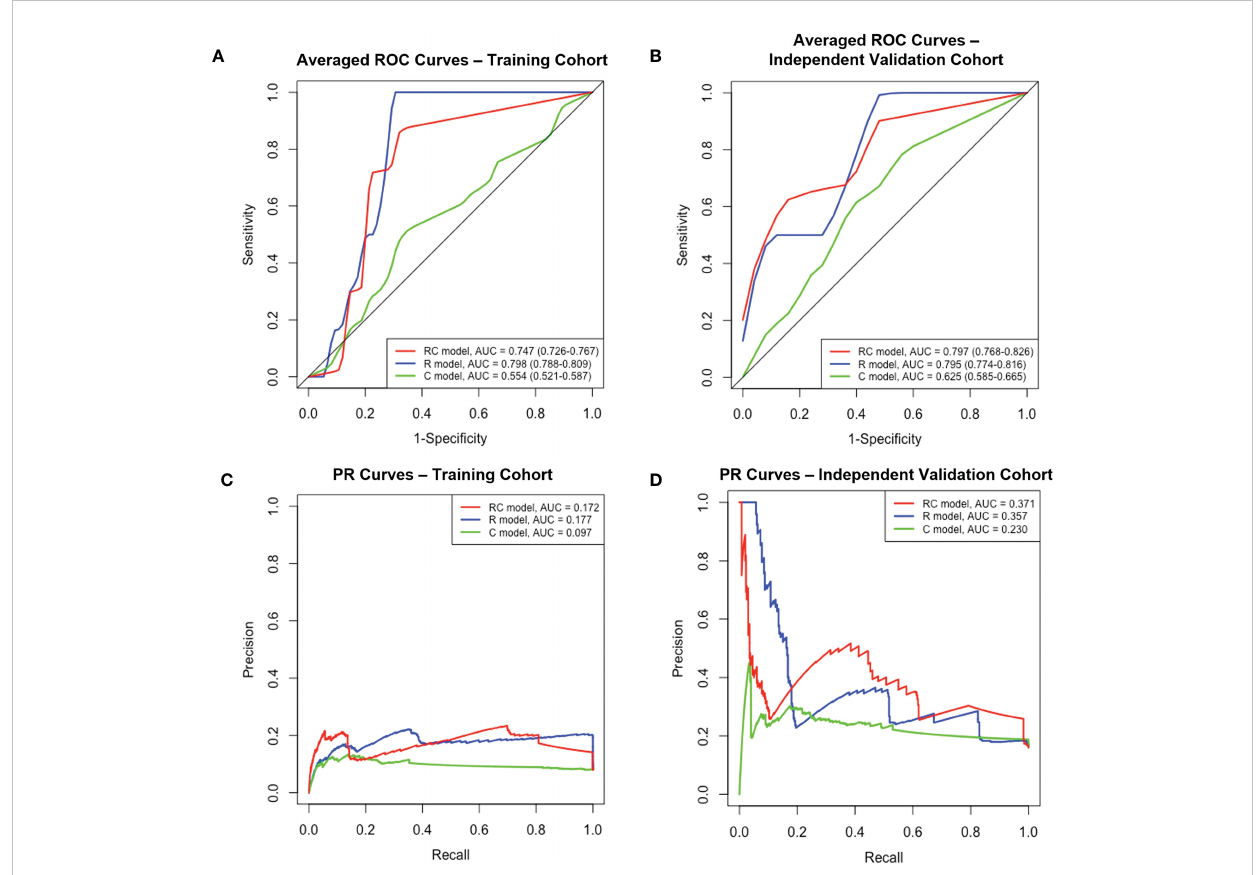
FIGURE 4 The ROC and PR curves of R, C and RC combined models. Boxplots (A, B) Averaged ROC curves of the training and independent validation cohort. Boxplots (C, D) The PR curves of both cohorts. ROC, receiver-operating characteristic; PR, precision-recall; R, radiomic; C, clinical; RC, radiomic- clinical; AUC, area under